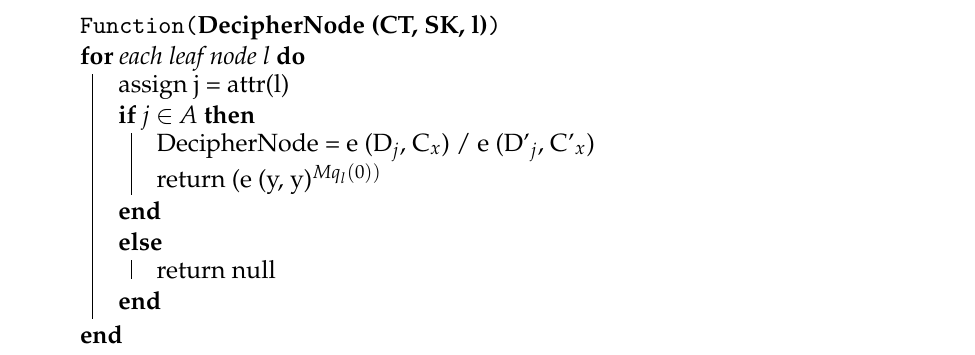
Algorithm 5: Algorithm for Node Decryption